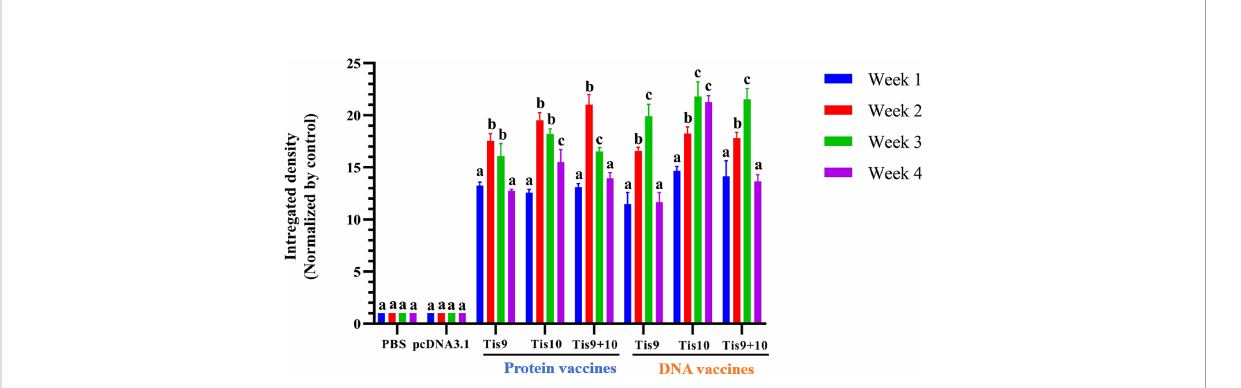
FIGURE 4 Dot blot analysis for identi fi cation of antibody production from vaccinated fi sh. Integrated densities from dot blot results were converted to values and normalized to the PBS or pcDNA3.1 negative control group using Image Lab software (Bio-Rad). Data are represented as means ± SD (n = 3). Different letters above the bars indicate signi fi cant differences within treatments (P <